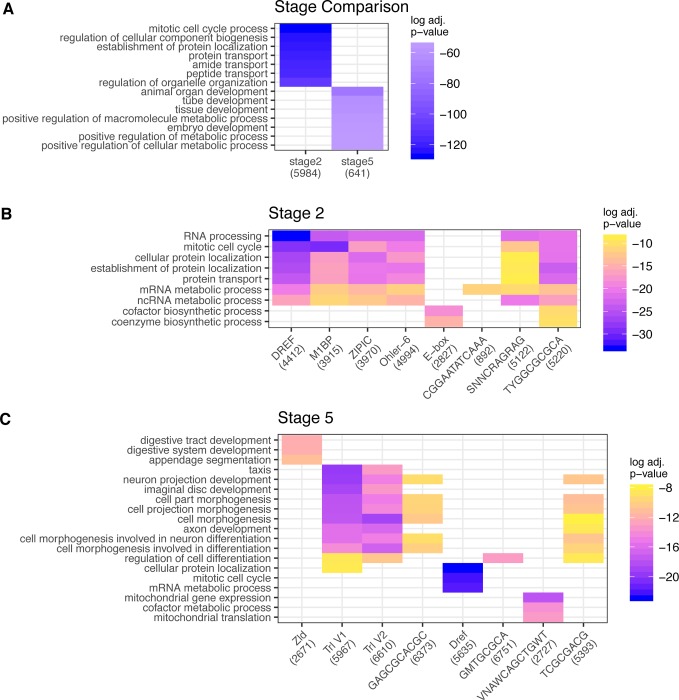
Top GO terms show that motifs regulate broader set of genes at the maternal stage, and a more specific set of developmentally associated genes at the zygotic stage.(A) GO terms associated with each stage. Note that the set of identified GO categories does not overlap between stages. (B) GO terms associated with top motifs in stage 2, where a majority of motifs are associated with similar broad GO categories (C) GO terms associated with top motifs in stage 5, some motifs are associated with the same categories, some appear to be more specialized, with identified categories showing more specificity than categories associated with stage 2.